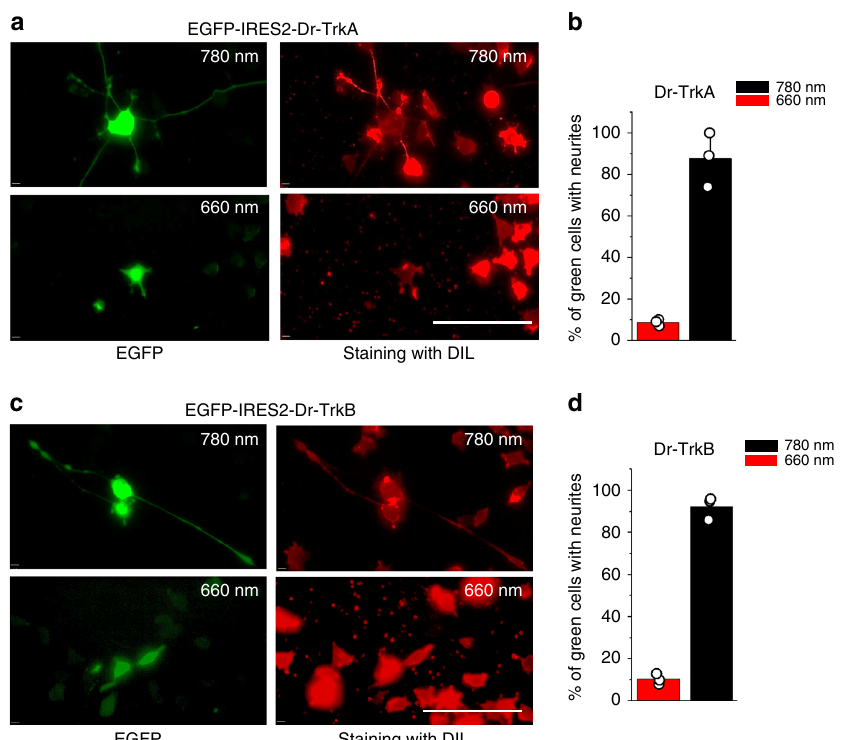
Fig. 6 Light-dependent neurite outgrowth in PC6-3 cells. a Epi fl uorescence images of PC6-3 cells transfected with the pEGFP-IRES2-Dr-TrkA plasmid kept for 72 h under either 780 nm (upper panels) or 660 nm (lower panels) light. Before imaging, the cells were fi xed and stained with a Dil reagent. Fluorescence images were taken in EGFP (left) and Dil (right) channels. b Quanti fi cation of cells bearing neurites from the total number of 50 cells transfected with the pEGFP-IRES2-Dr-TrkA plasmid. c Epi fl uorescence images of PC6-3 cells transfected with pEGFP-IRES2-Dr-TrkB plasmid kept for 72 h under either 780 nm (upper panels) or 660 nm (lower panels) light. Before imaging, cells were fi xed and stained with a Dil reagent. Fluorescence images were taken in EGFP (left) and Dil (right) channels. d Quanti fi cation of the cells bearing neurites from the total number of 50 cells transfected with the pEGFP-IRES2-Dr-TrkB plasmid. Error bars represent s.d., n = 3 experiments. Scale bar, 100 µ